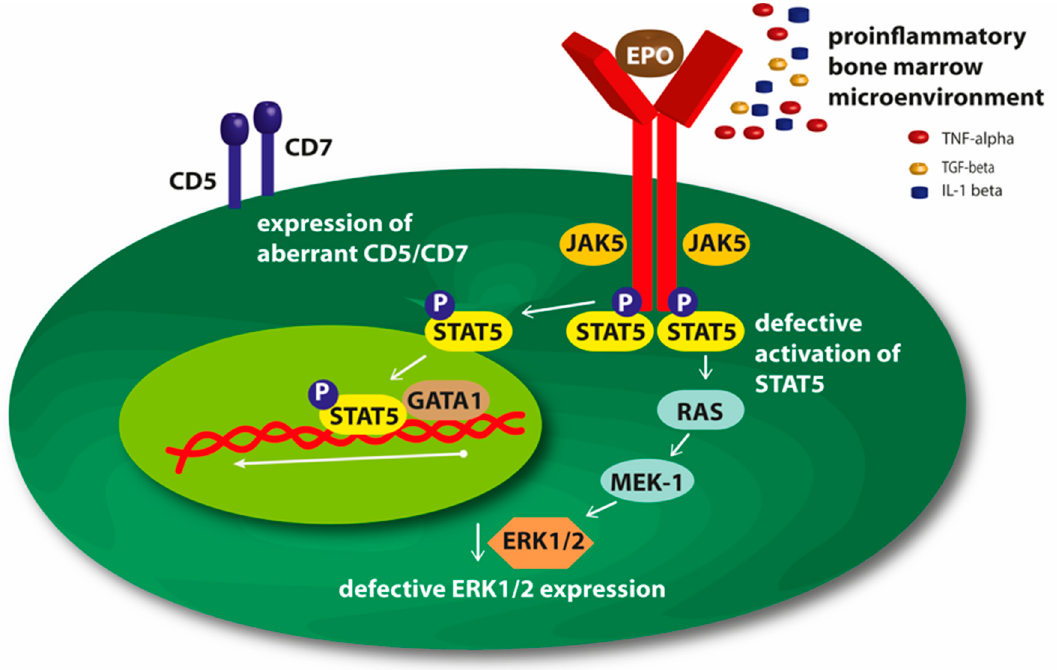
Figure 1. Mechanisms of resistance to erythropoiesis-stimulating agents (ESAs).